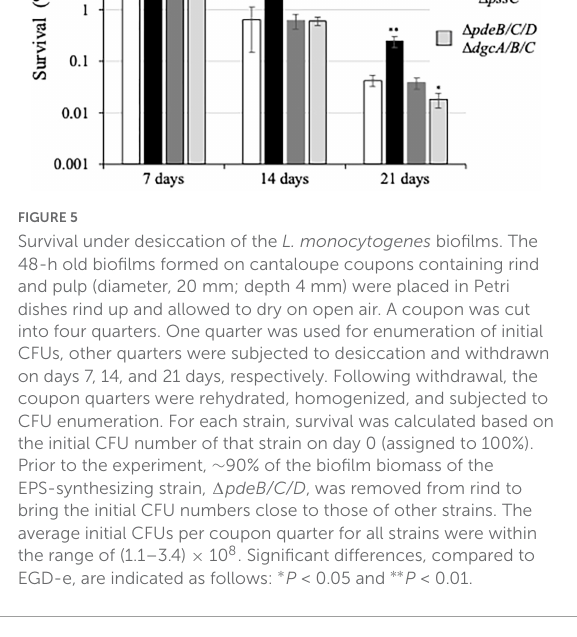
EPS-biofilms formed on fresh produce could survive storage and transportation of fresh produce much better than biofilms formed by the strains not synthesizing